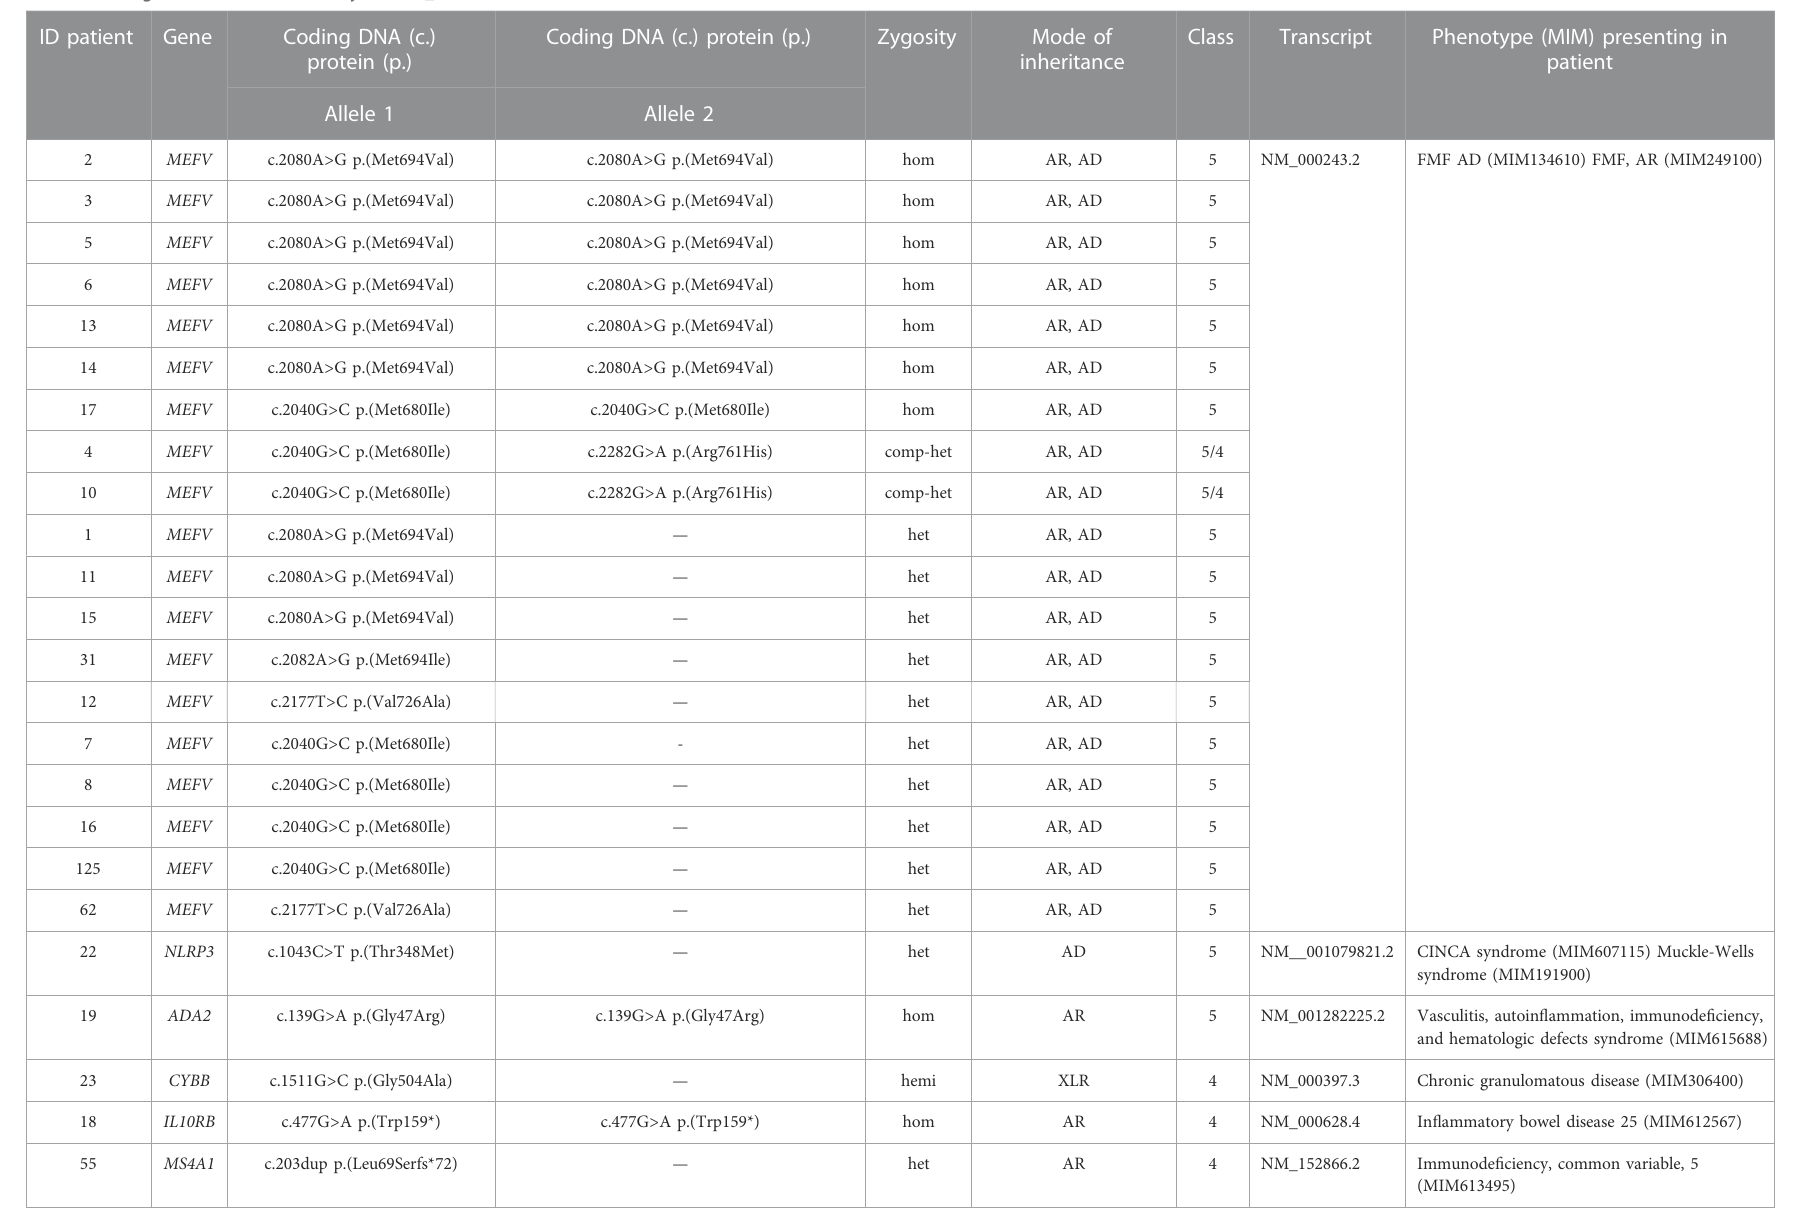
TABLE 1 Pathogenic variants identi fi ed by